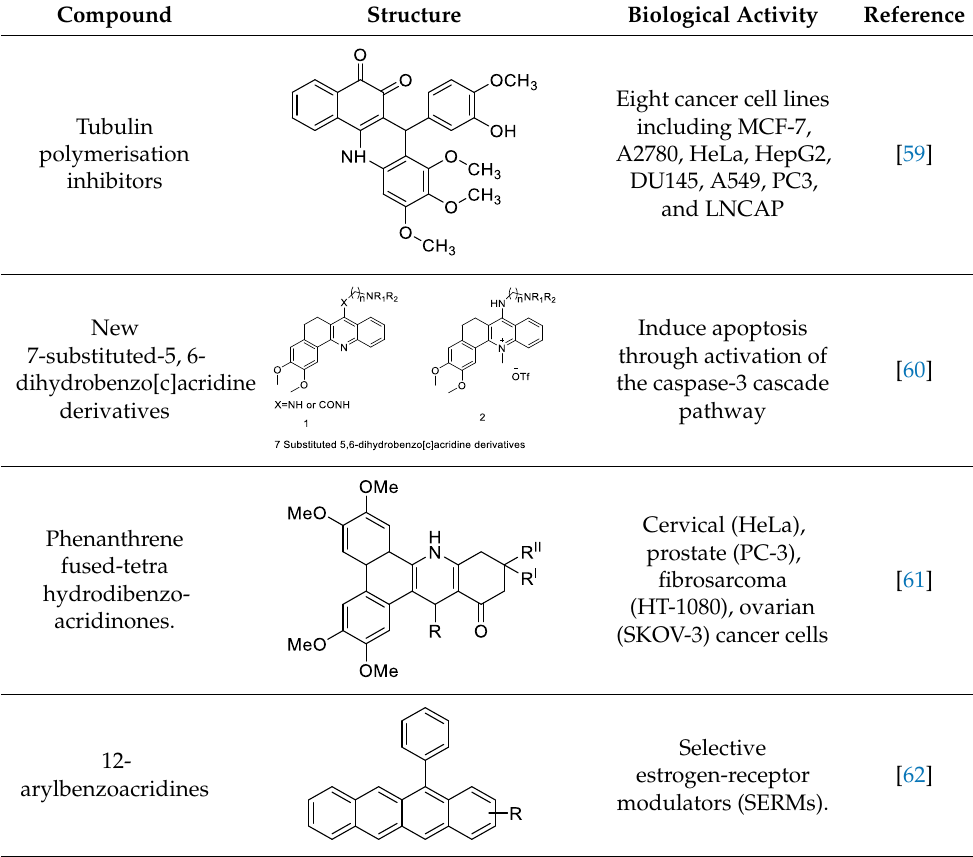
Table 8. Benzoacridine as an anti-tumour agent.